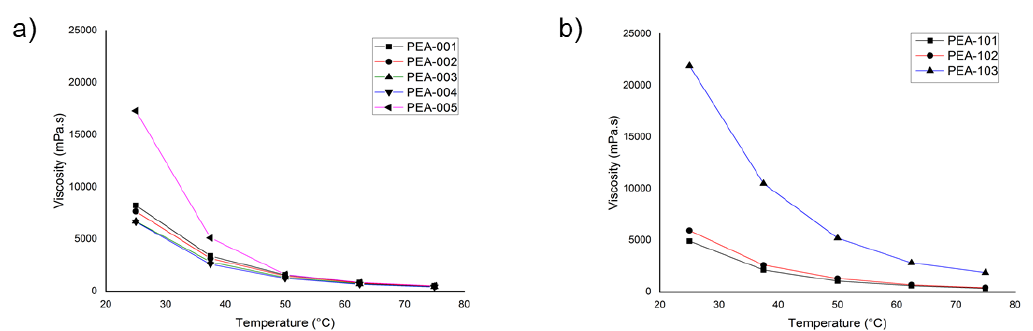
Figure 4. Viscosity curves of PEA synthesized in the course of this study. (a) PEA-001-005; (b) PEA-101-103.